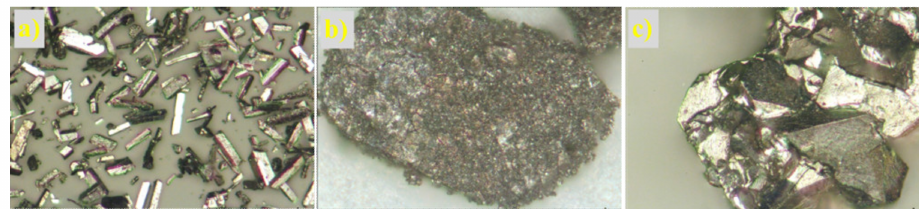
Figure 12. Microphotographs of the samples at 25 × magnification: ( a ) HMT-AHM-700,